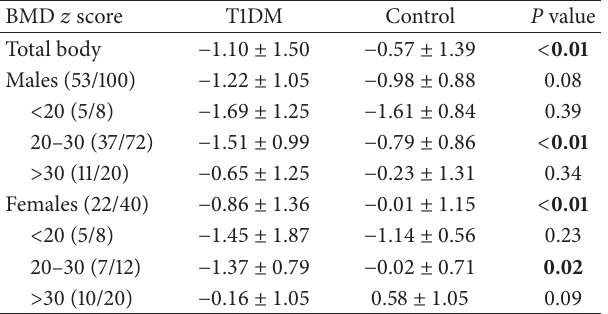
BMD: bone mineral density; T1DM: type 1 diabetes mellitus. The numbers in brackets indicate the number of subjects in each subgroup cases and controls. For example, males (53/100) to be read as 53 T1DM cases and 100 healthy controls were in this